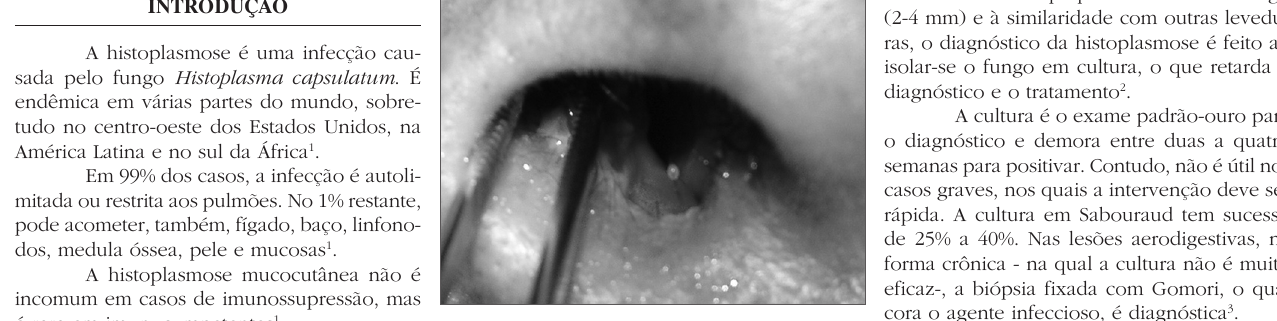
Figura 1. Lesão ulcerada em vestibulo nasal